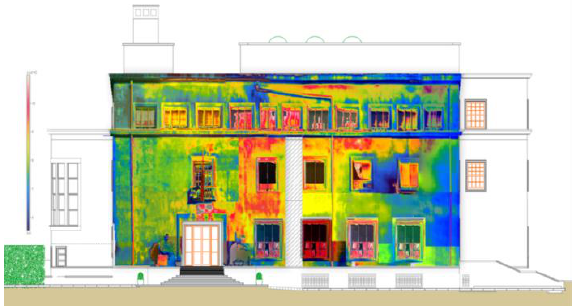
Figure 2. IR thermography image representing the water infiltration (in blue) form the right side of the roof (Brigate Palace, Tirana,